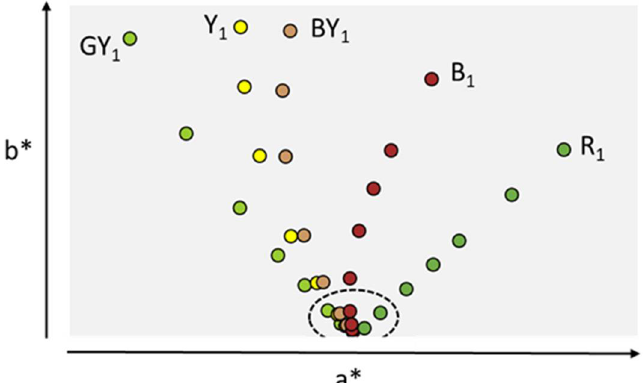
Figure 2. Instrumental determination of a* and b* parameters for EP standards plotted in Cartesian 2D spectral graph. GY stands for Green-Yellow, Y for Yellow, BY for Brown-Yellow, B for Brown, and R for Red. Highest chroma (Intensity 1) for each hue (color series) is shown. Dotted line circle indicates color intensities equal to 6 and above in each color series, not distinguishable by visual observation. Data (a*, b*) are from reference [26].